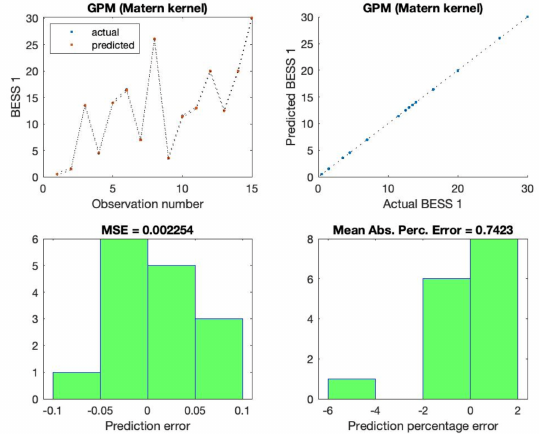
Figure 14. Machine learning results of the GPM mdl for BESS 1.